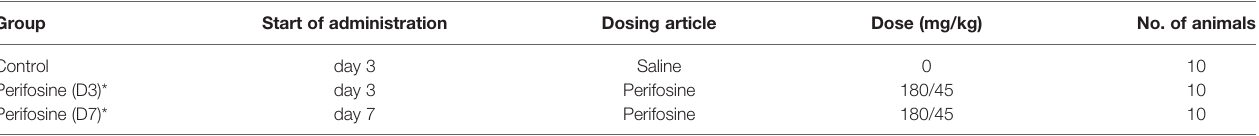
TABLE 2 | Group con fi guration in the H1915 intracranial orthotopic brain metastasis model.